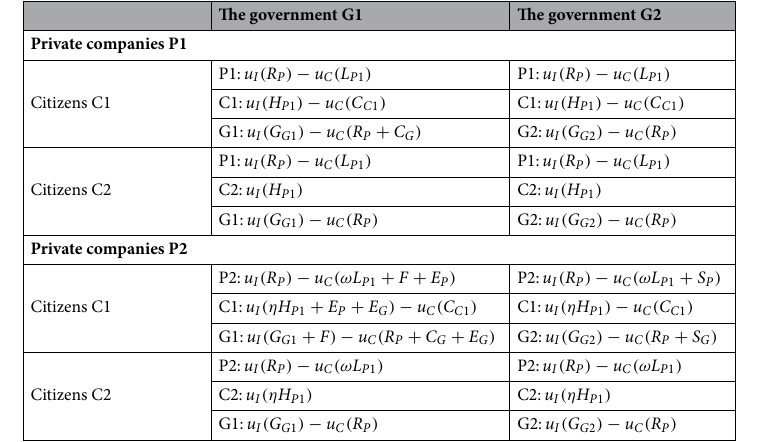
Table 2. Perceived payoff matrix based on Prospect Theory and Mental